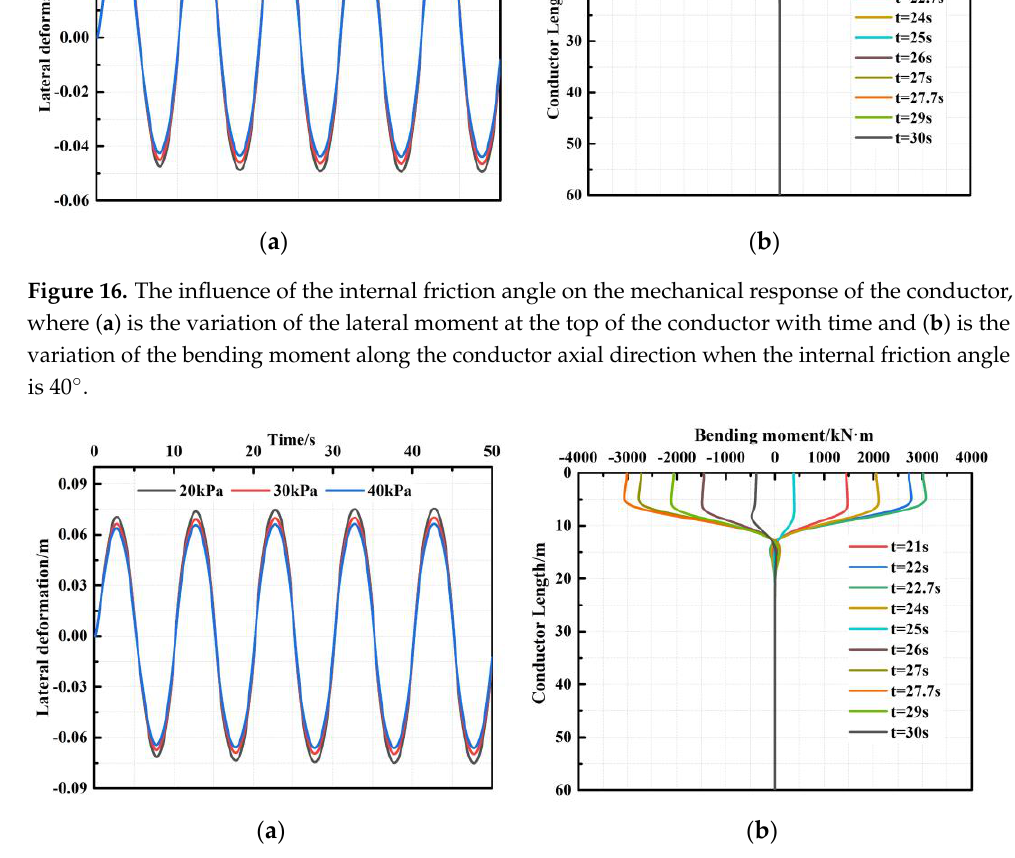
Figure 17. The influence of cohesion on the mechanical response of the conductor, where ( a ) is the variation of the lateral moment at the top of the conductor with time and ( b ) is the variation of the bending moment along the conductor axial direction when the cohesion is 20 kPa.